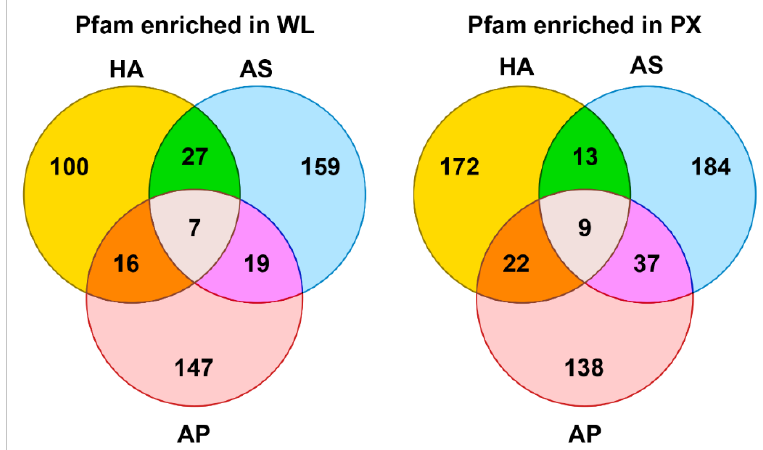
Figure 2. Venn diagrams. Venn diagrams showing numbers of p-families found enriched in the whole larvae (WL) and in the pharyngeal tissue (PX) of Hysterothylacium aduncum (HA), Anisakis simplex s.s. (AS) and A. pegreffii (AP).